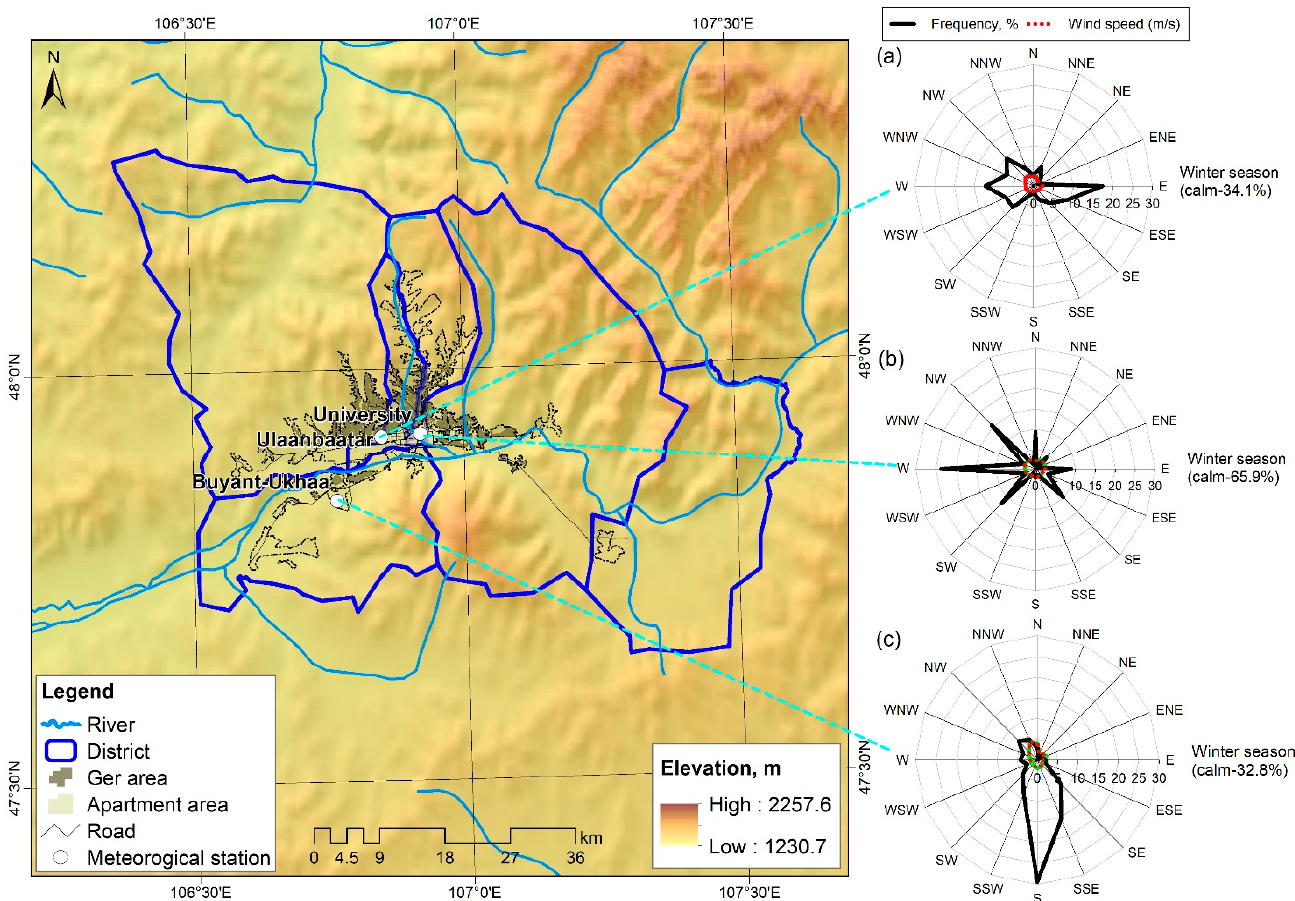
Figure 8. Windrose diagrams at Ulaanbaatar city’s weather stations in the winter: ( a ) Ulaanbaatar station, ( b ) University station, and ( c ) Buyant-Ukhaa station.